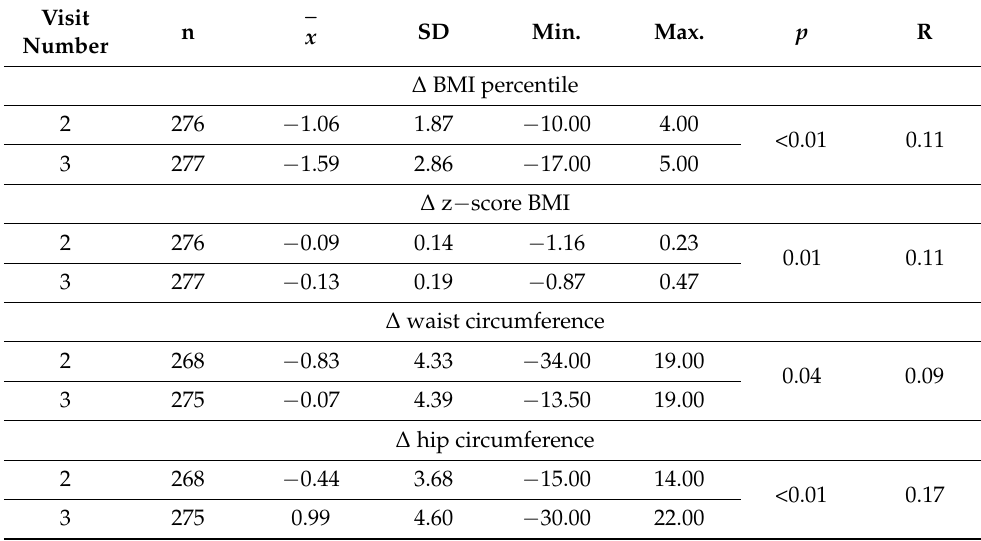
Table 6. Change in time and anthropometric parameters in group